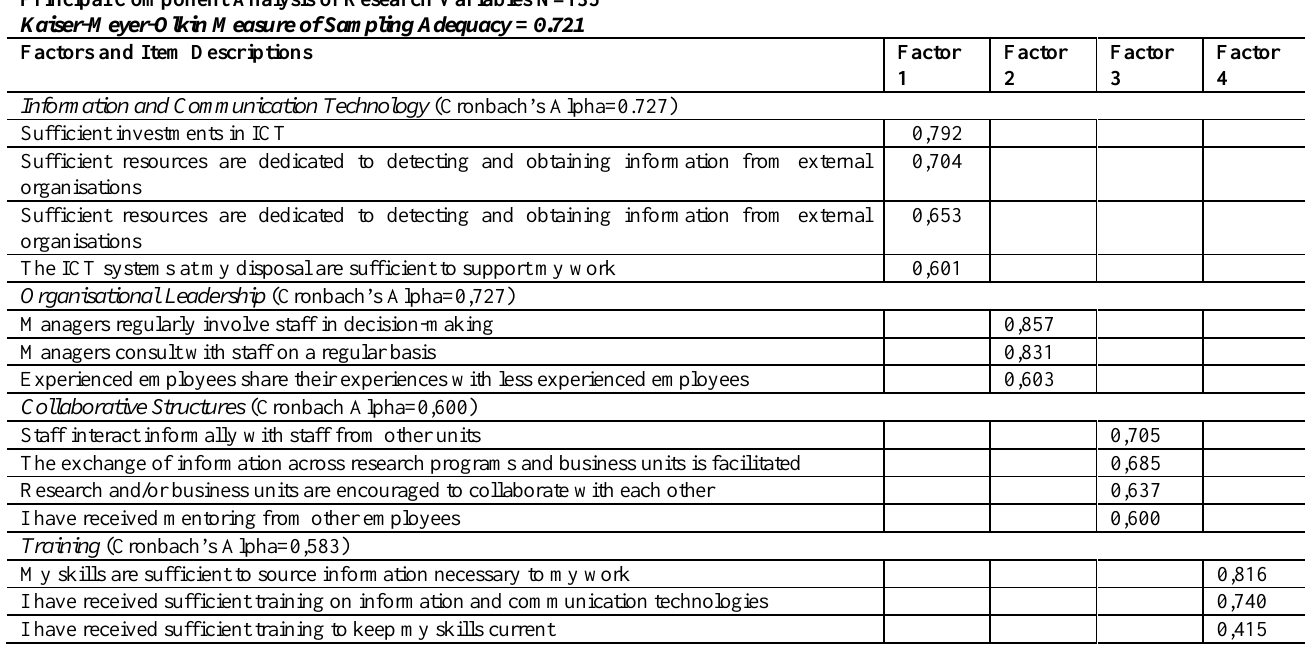
Table 2: Principle component analysis – organisational practices Principal Component Analysis of Research Variables N=135 Kaiser-Meyer-Olkin Measure of Sampling Adequacy = 0.721 Factors and Item